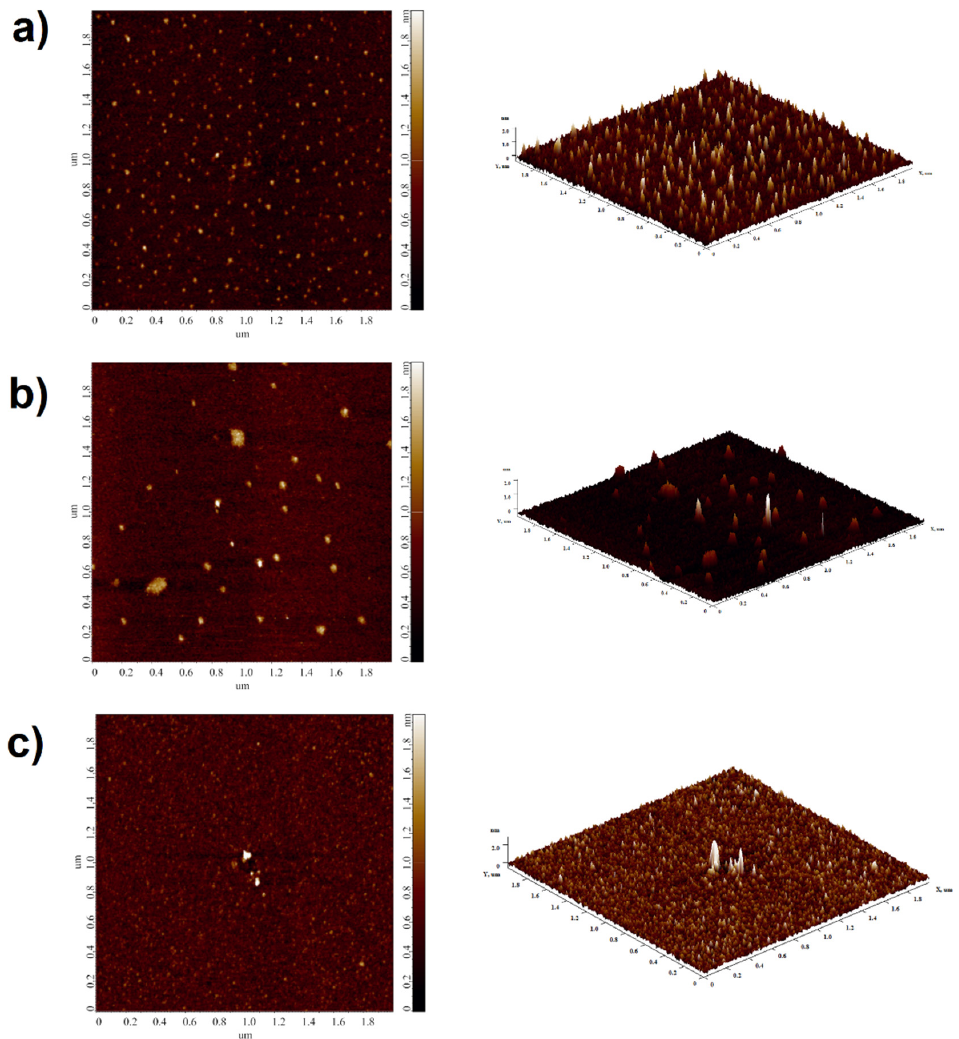
Figure 3. Typical AFM 2D (left) and 3D (right) images of HRP adsorbed on mica from its solutions incubated either 1 cm below the ISP’s apex ( a ), 1 cm above the ISP’s base ( b ) or three meters away from the ISP ( c ) (control sample). The scan size of all the images is 2 µm × 2 µm, Z scale is from 0 to 2 nm.